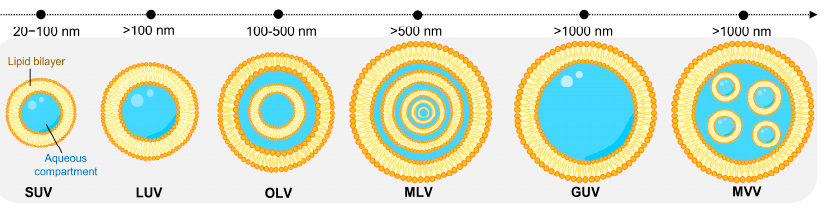
Figure 2. Visual representation of the different classes of liposomes based on size and lamellarity. SUV: small unilamellar vesicle; LUV: large unilamellar vesicle; OLV: oligolamellar vesicle; MLV: multilamellar vesicle; GUV: giant unilamellar vesicle; MVV: multivesicular vesicle. Liposomes can also be further subdivided according to their composition and application (Table 1) [22,26,27]. Table 1. Classification of liposomes based on their composition and properties [22,26,27].